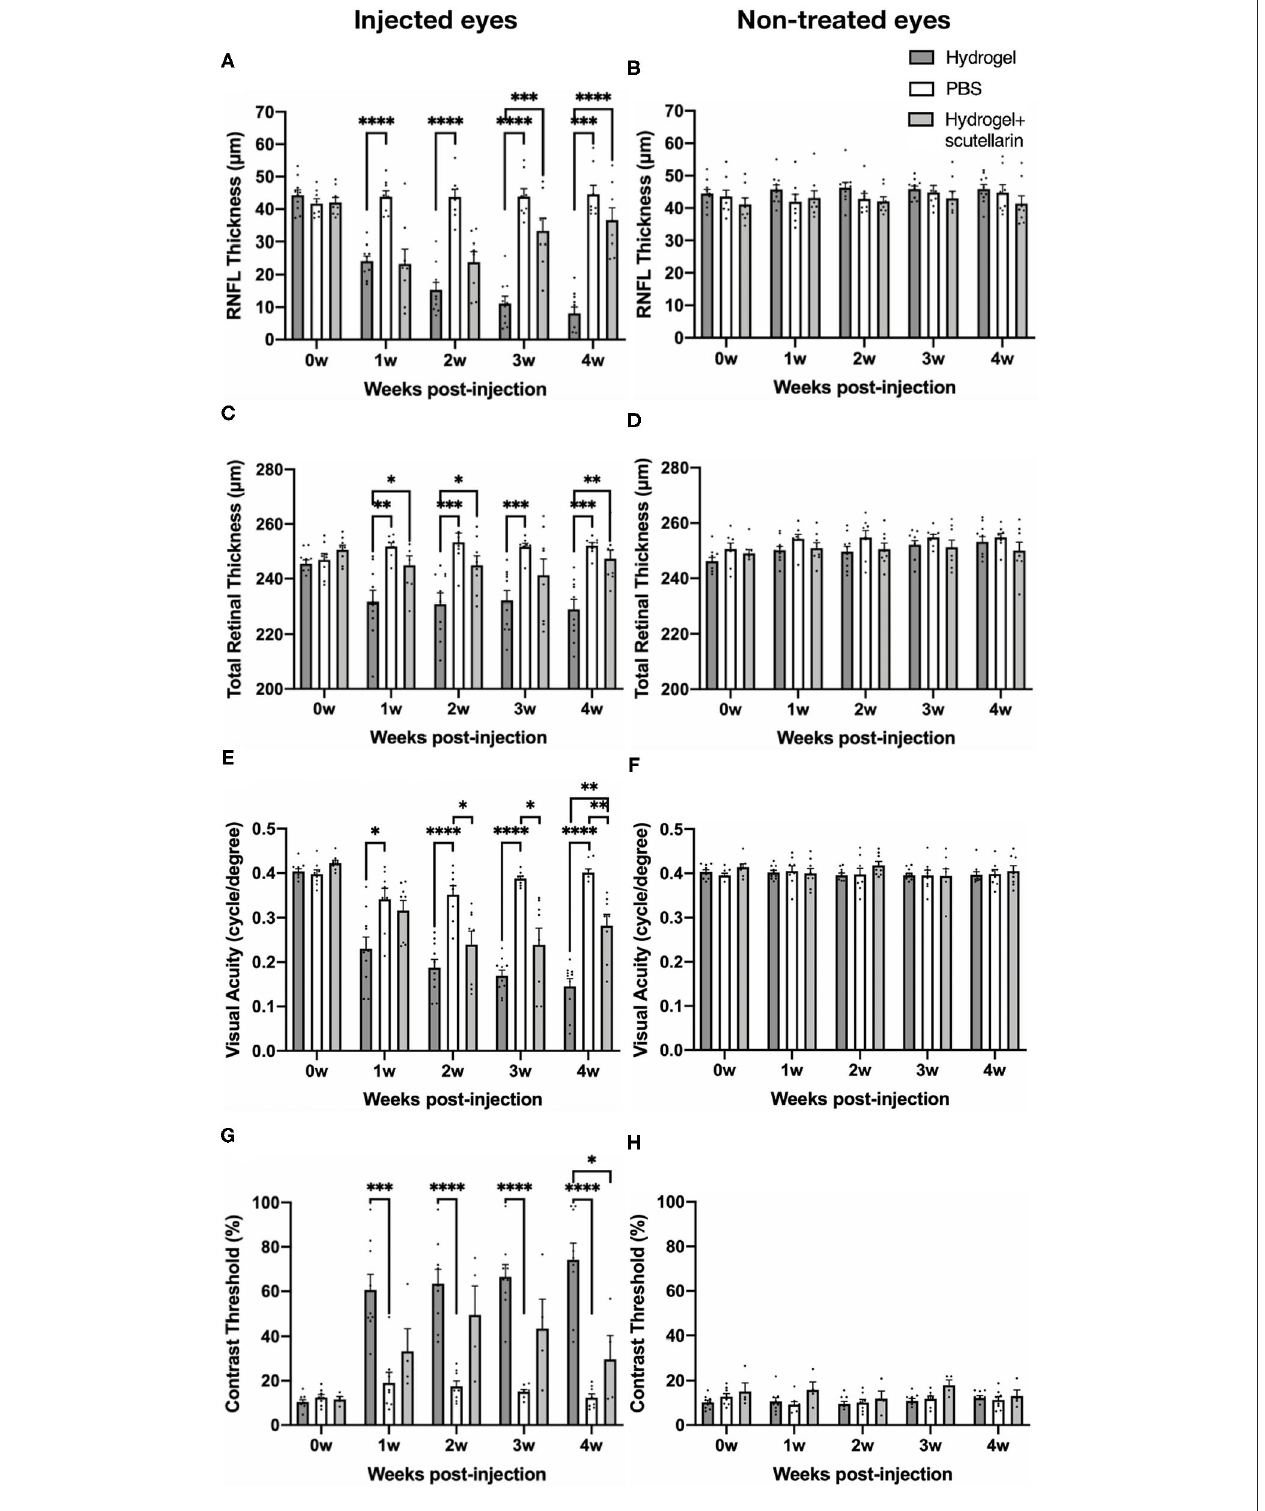
FIGURE 3 | Quantitative analyses of retinal nerve fiber layer (RNFL) thickness, total retinal thickness (TRT), visual acuity, and contrast threshold in the injected (left column) and contralateral, non-treated eyes (right column) among the hydrogel-only group (Group 1, dark gray bar), phosphate-buffered saline (PBS) group (Group